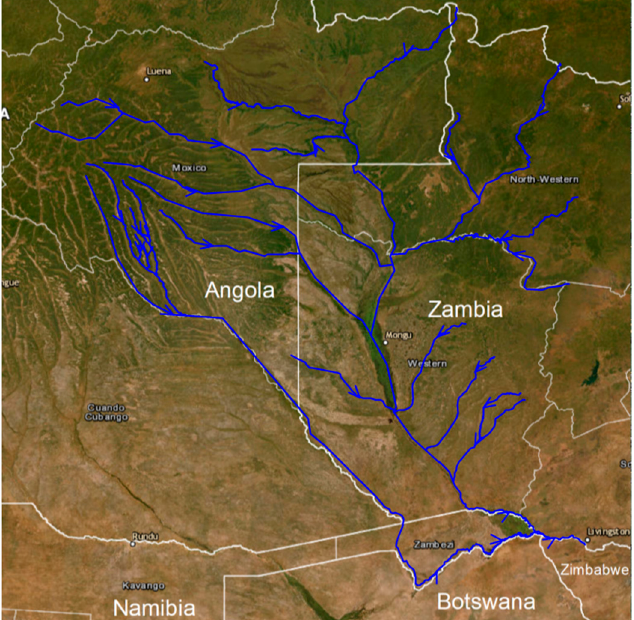
Figure 13. Map of the Upper Zambezi River Basin region in Africa showing the main river branches of the basin in blue.